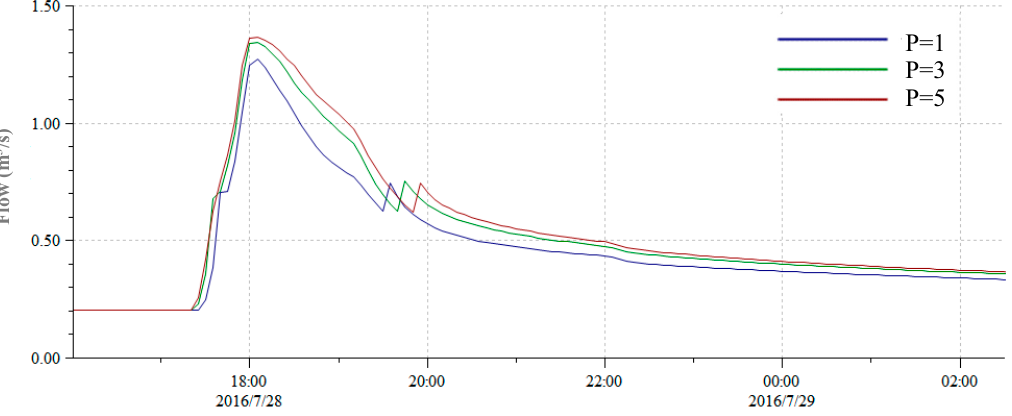
Figure 6. Interception flow curve of traditional interception weir.